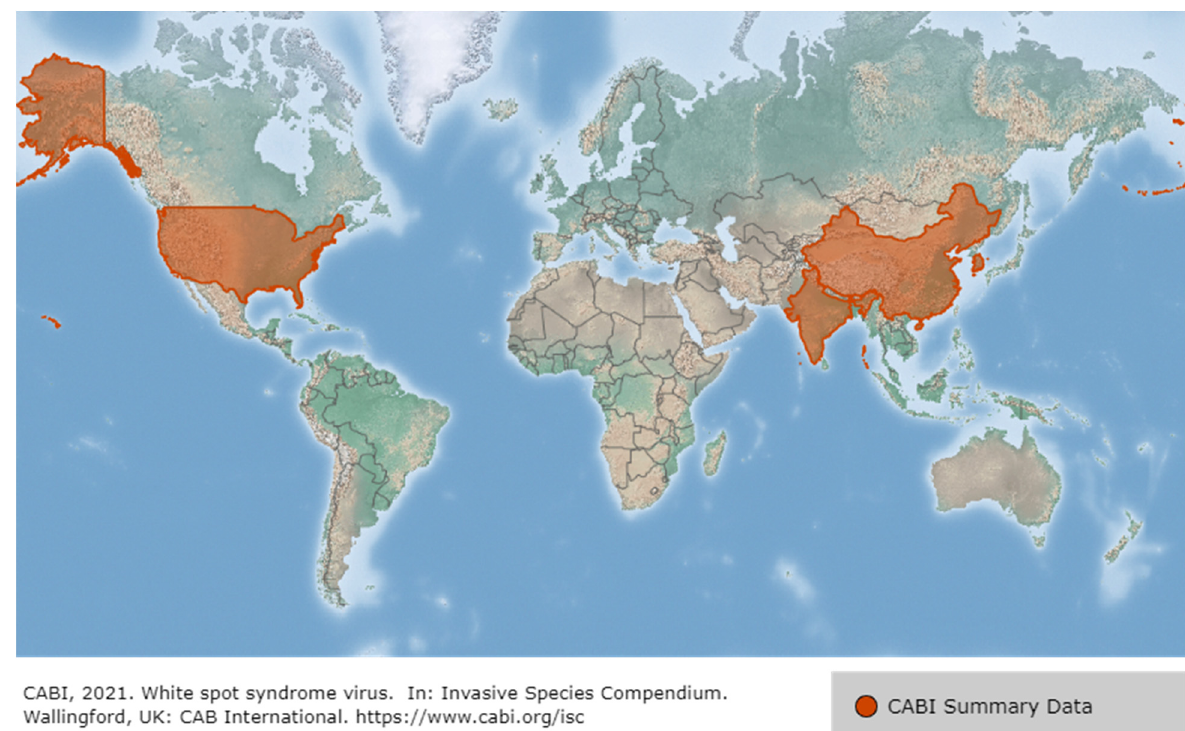
Figure 5. Distribution map showing the geographical occurrence of white spot syndrome disease (WSSD) (Reprinted from CABI, 2019, White spot syndrome virus. In: Invasive Species Compendium. Wallingford, UK: CAB International, with permission from CABI).